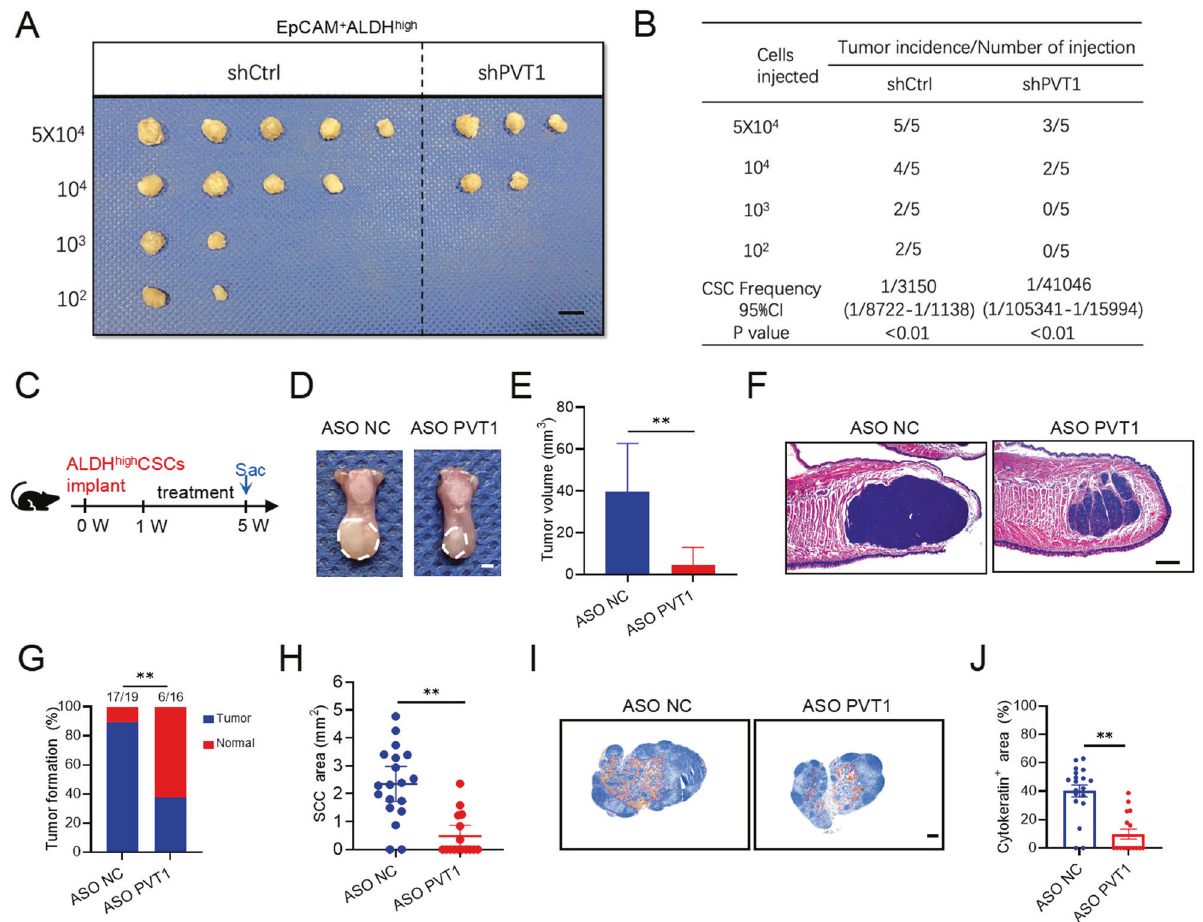
Fig. 4 PVT1 KD suppresses the metastasis of HNSCC cells. A , B Extreme limiting dilution analysis (ELDA) of EpCAM + ALDH high tumor cells transfected with shCtrl and shPVT1 in vivo ( n = 5). The frequency of allograft formation was displayed for each cell dose injected. ELDA software was used to analyze the data. Scale bar: 1 cm. C Schematic diagram of the time points of ASO PVT1 treatment and sacri fi ce (Sac) of mice injected with ALDH high CSC-like cells from HN6 cells. D Representative image of nude mice orthotopic tumors in the tongue from the mice in the different treatment groups. The lesion areas are circled with a white dotted line. Scale bar, 2 mm. E Quanti fi cation of the tumor volume of nude mice in the different treatment groups. Data are shown as the mean ± SD from at least two independent experiments. ** p < 0.01 using an unpaired Student ’ s t-test. F H&E-stained HNSCC from nude mice in the different treatment groups. Scale bar, 500 μ m. G Quanti fi cation of the number of tumors in the nude mice in the different treatment groups. Data are shown as the mean ± SD from at least two independent experiments. ** p < 0.01 using a χ 2 test. H Quanti fi cation of the area of the tumors in the nude mice in the different treatment groups. Data are shown as the mean ± SD from at least two independent experiments. ** p < 0.01 using an unpaired Student ’ s t-test. I A representative image of anti-PCK immunostaining of cervical lymph nodes. Scale bar, 200 μ m. J Quanti fi cation of lymph node metastatic areas of nude mice in the indicated treatment groups. Data are shown as the mean ± SEM from at least two independent experiments. ** p < 0.01 using an unpaired Student ’ s